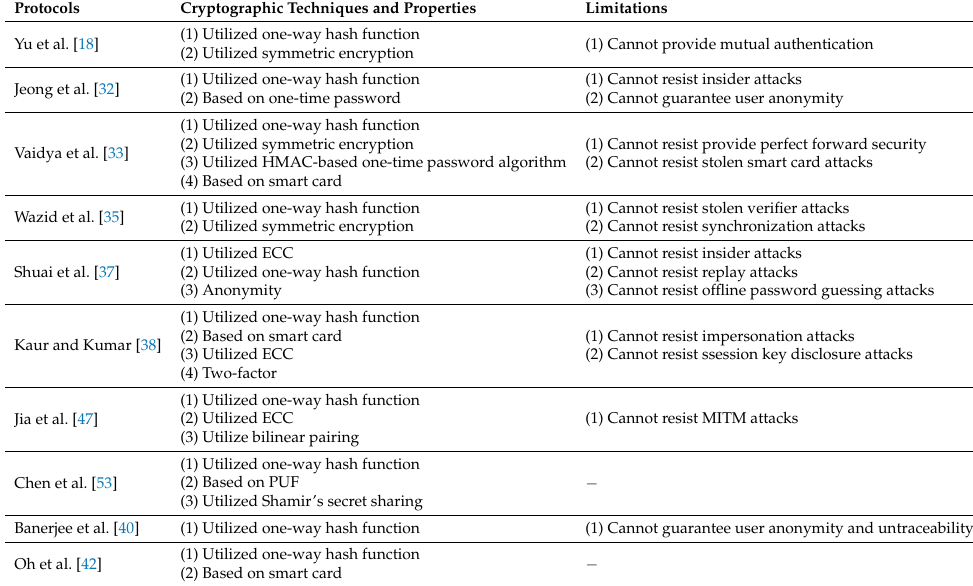
Table 1. The summary of authentication